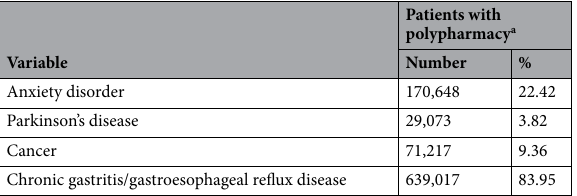
Table 1. Characteristics of study patients with polypharmacy in 2014–2018 (n = 761,145). a Categorical variables are expressed as frequencies and percentages, and continuous variables are expressed as mean values with standard deviation.